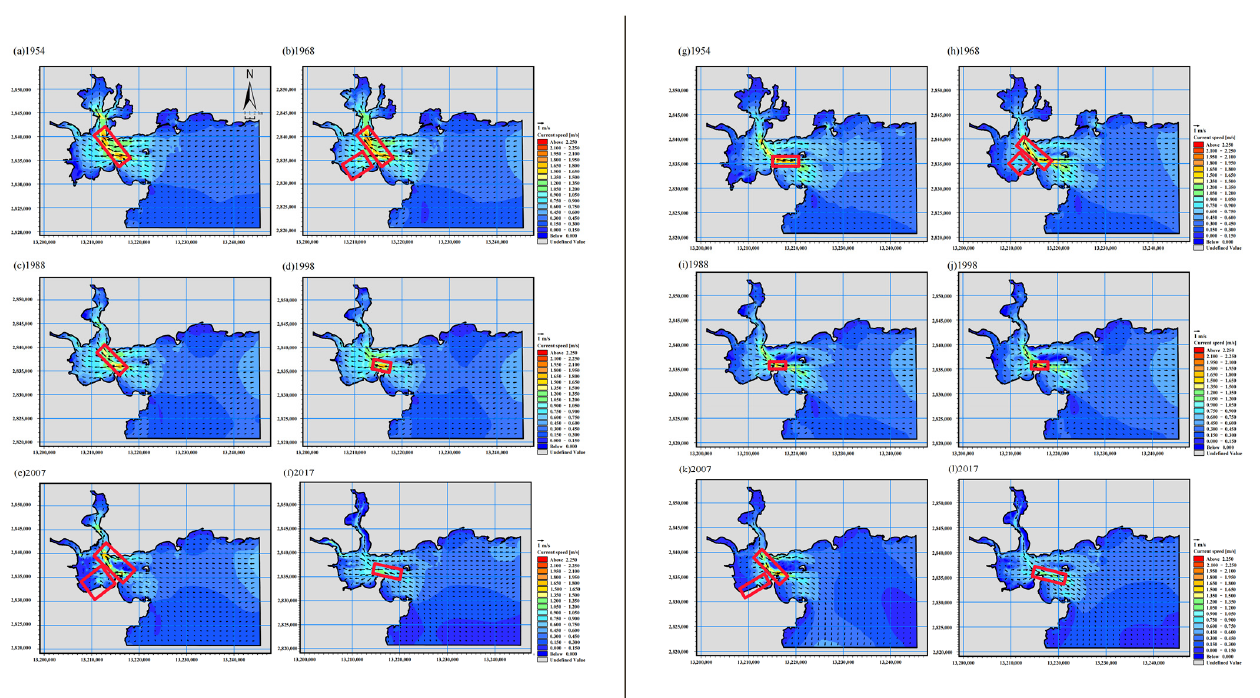
Figure 5. Changes in the tidal current field of the rising and falling tides in Quanzhou Bay during different periods. ( a – f ) The distribution of the hydrodynamic forces during the flood tide in different years. ( g – l ) The distribution of hydrodynamic forces during the ebb tide in different years.